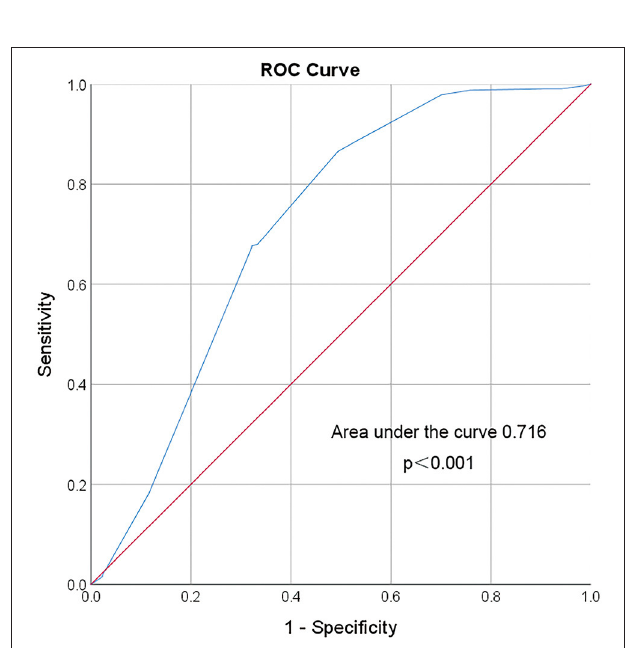
FIGURE 6 | ROC curve of the lowest SBP before VA ECMO initiation. Area under the ROC Curve of the lowest systolic blood pressure (72.5 mmHg) before VA ECMO initiation for predicting incidence of neurologic complications during ECMO is 0.716 (95% CI 0.647–0.786). The red line indicates reference